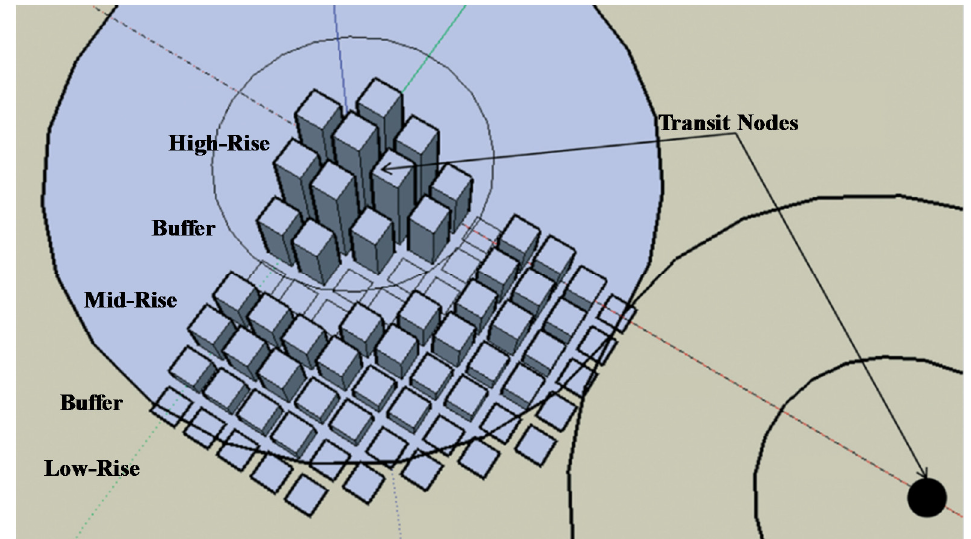
Figure 14. Land use in relation to density and transit nodes [2].